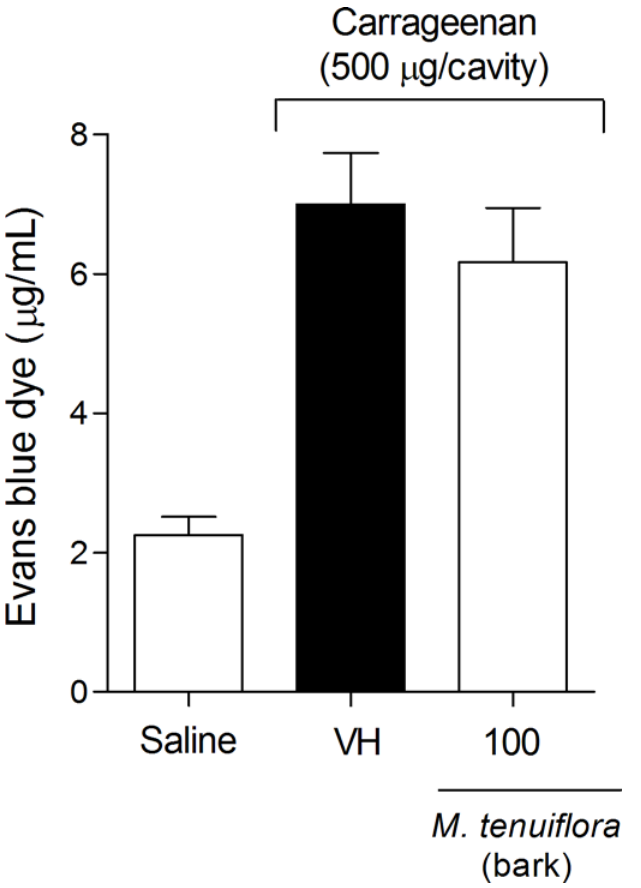
Fig 6. Effect of ethanolic extract of M . tenuiflora bark on vascular permeability using the Evans blue test. VH is the vehicle group (negative control). The ethanol extract of M . tenuiflora bark was tested at the 100 mg/kg (s.c.) dose. The results are presented as the mean ± S.D. (n = 8). Statistical significance was calculated by ANOVA followed by Bonferroni's test. * P < 0.05 compared to the vehicle-negative control treated